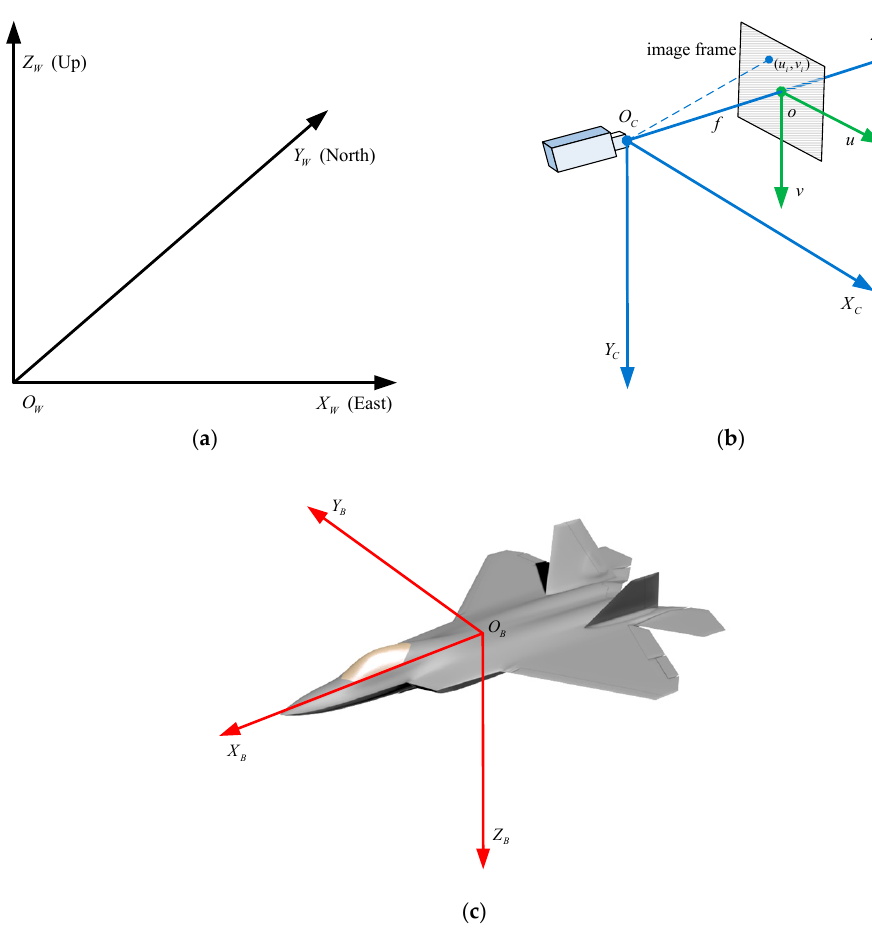
Figure 1. Coordinate systems: ( a ) world coordinate frame; ( b ) camera coordinate frame and image frame; ( c ) body coordinate frame.